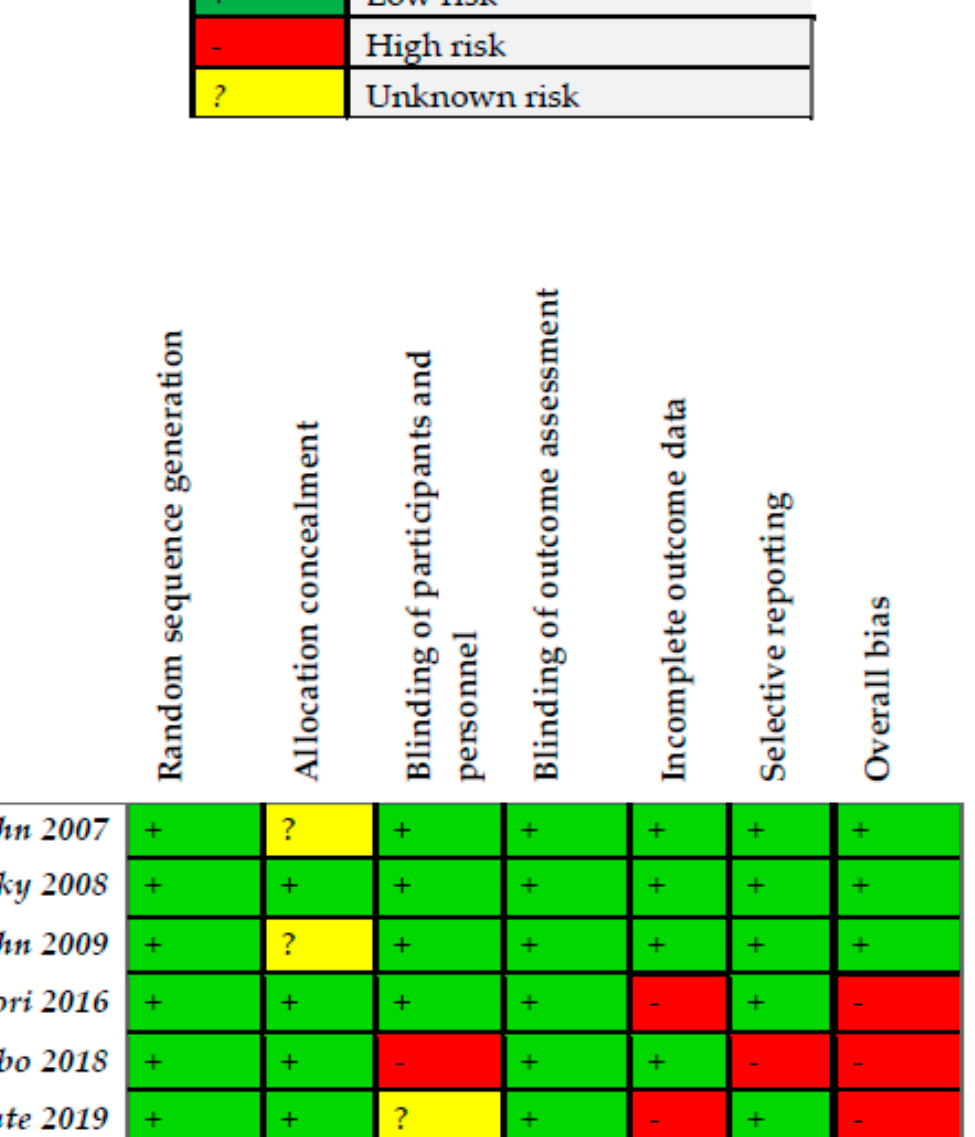
Figure 2. Risk of bias of the included trails for PBM.